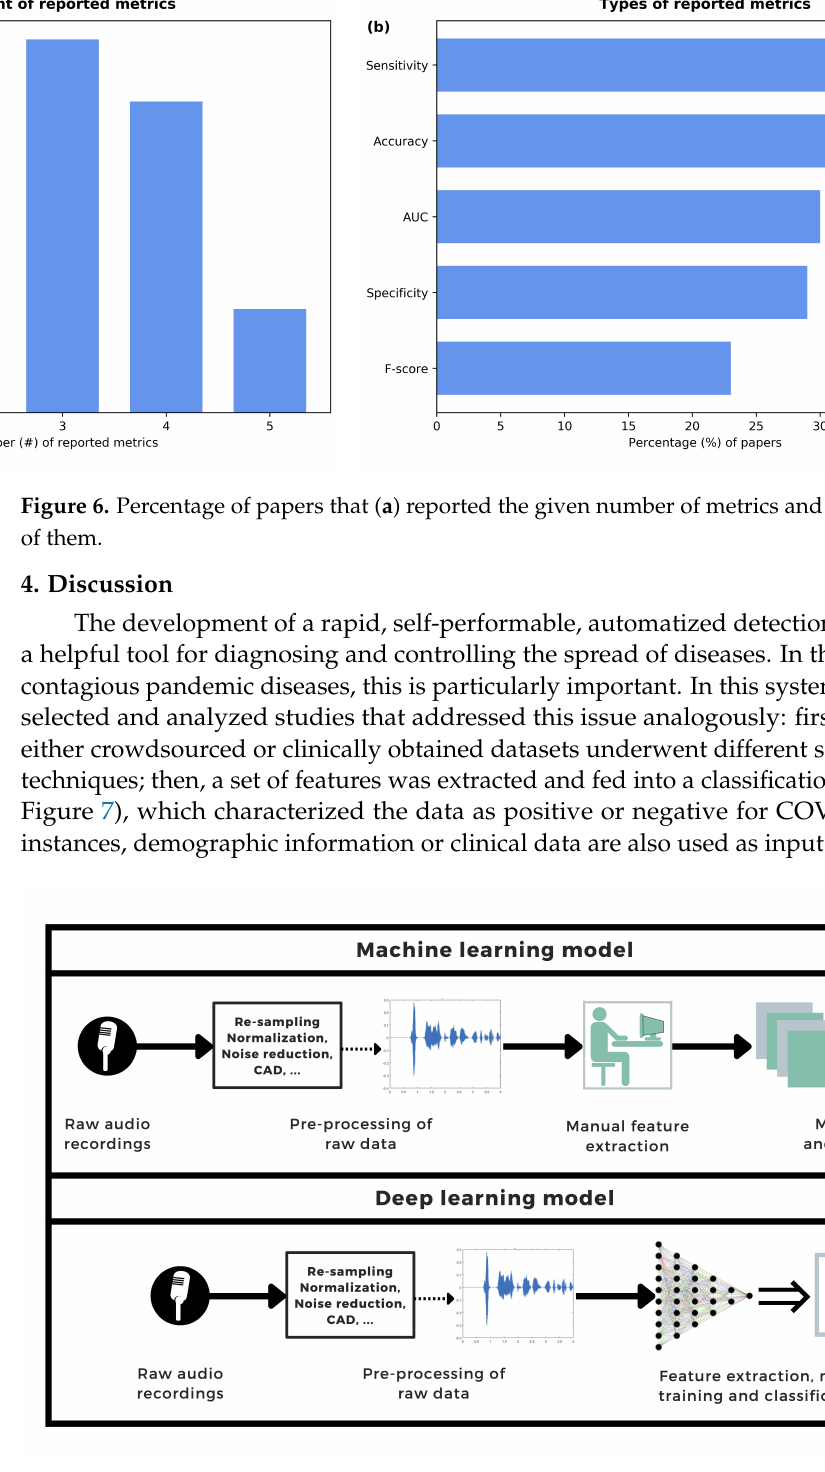
Figure 7. General workflow diagram of common machine learning- and deep learning-based COVID- 19 detection processes using audio